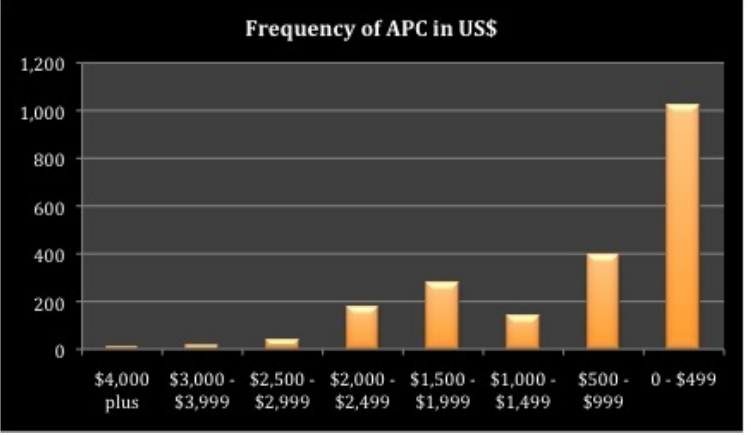
Figure 3. Frequency of OA APC by price